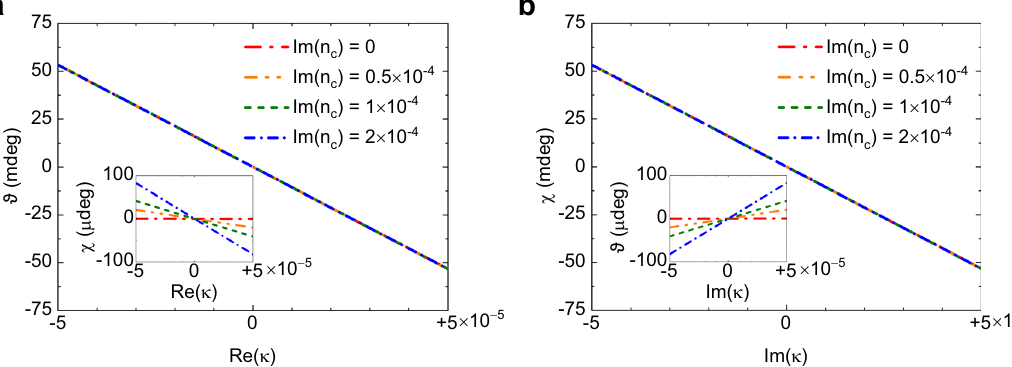
Fig. 3 Effect of the nonchiral loss term, Im( n c ), on chirality-dependent optical rotation ϑ and ellipticity angle χ . a Optical rotation ϑ and ellipticity angle χ (inset) as a function of chirality parameter κ ranging from − 5 × 10 − 5 to 5 × 10 − 5 (purely real κ ). b χ and ϑ (inset) as a function of κ ranging from − 5 × 10 − 5 i to 5 × 10 − 5 i (purely imaginary κ ). ϑ and χ are obtained from the CPA-locked S C with L c = 1 nm and n c = 1.33 + i Im( n c ), where L c and n c are the thickness and average refractive index of the chiral layers, respectively. Different values of Im( n c ) are represented by colors and CPA is an acronym for coherent perfect